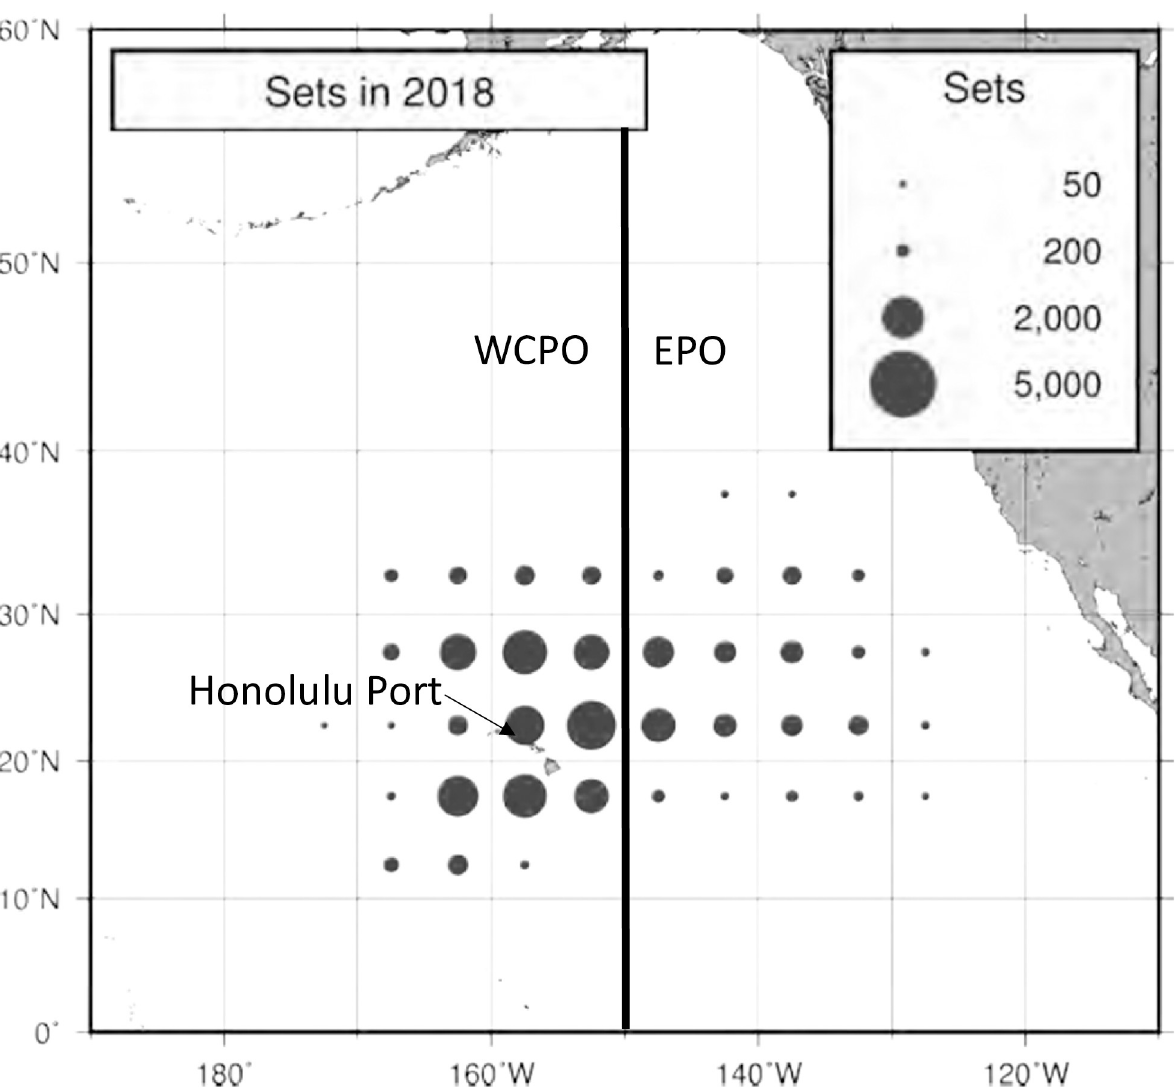
Fig 1. Hawaii longline fishery fishing areas: Spatial distribution of the total number of sets by longline vessels based in Hawaii and California fishing within the North Pacific Ocean, 2018 (provisional data). Source: PIFSC data report DR-12-047, https://doi.org/10.25923/dq48-ef09.